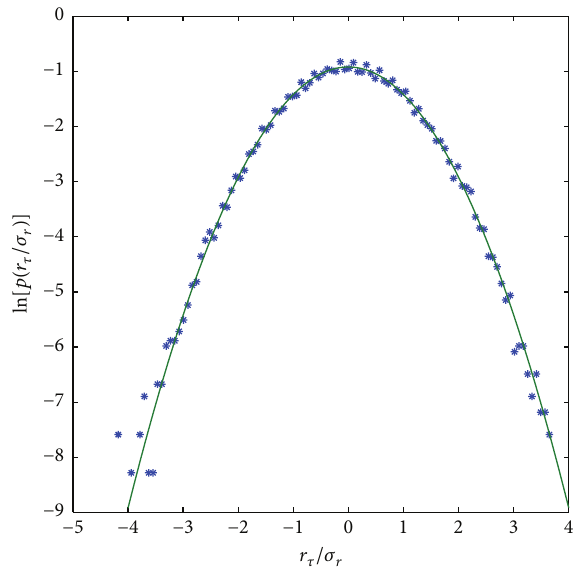
Figure1:WecomparetheGaussiandistribution(solidline)withthe pdf of log return with time scales 𝜏 = 8 ( ∗ -line) in the Ising case